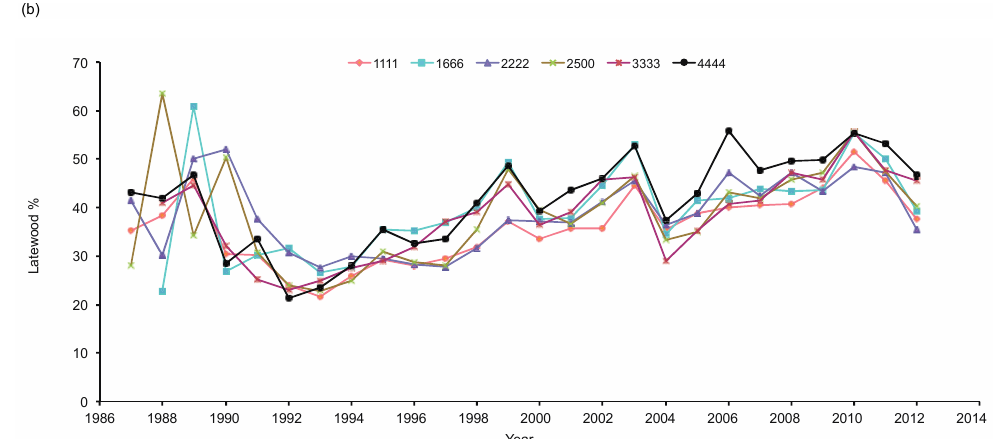
Figure 5. Annual wood density ( a ) and percentage of latewood ( b ) at different tree spacing for jack pine 25 years following planting in Quebec, Canada.